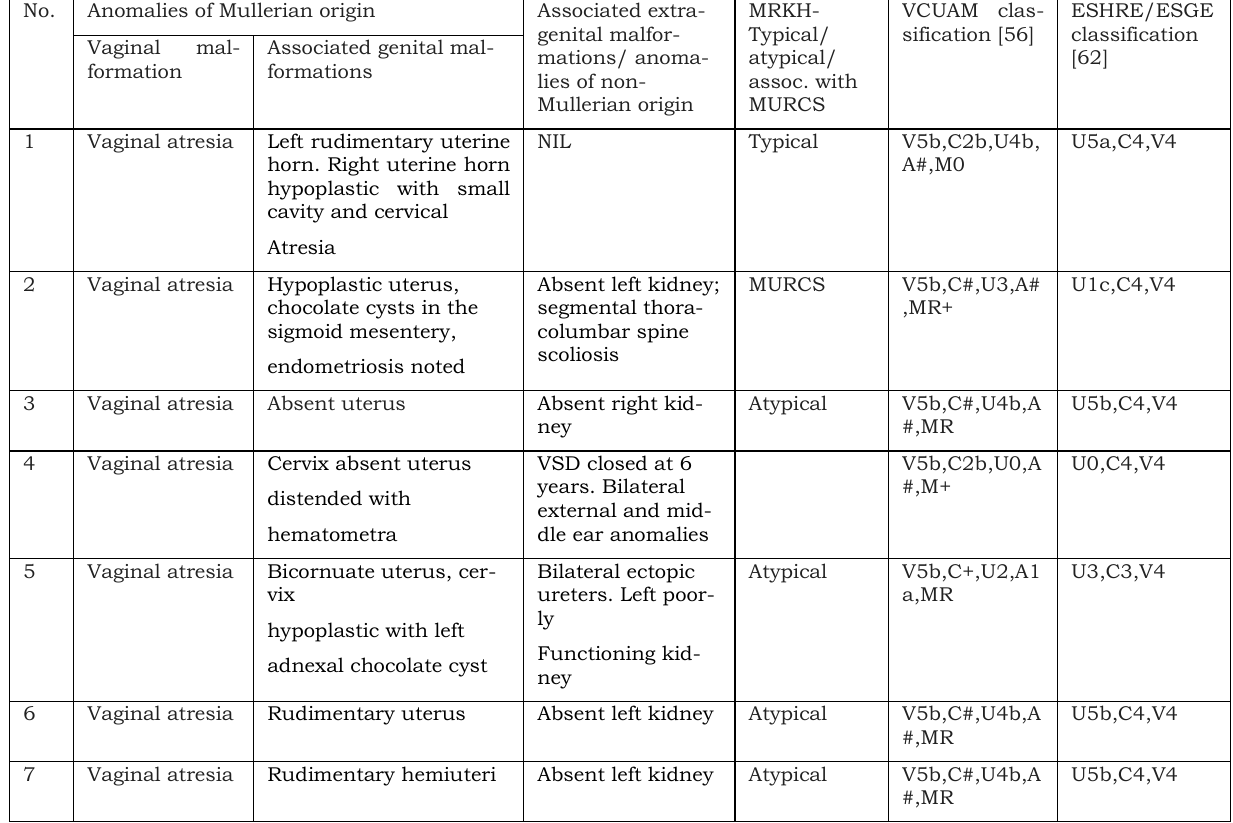
Table 3: Classification of seven patients of the rectovestibular fistula with vaginal atresia as per the anomalies (adapted with permission from Kisku et al. Pediatr Surg Int. 2014;30:6333-9).[43]